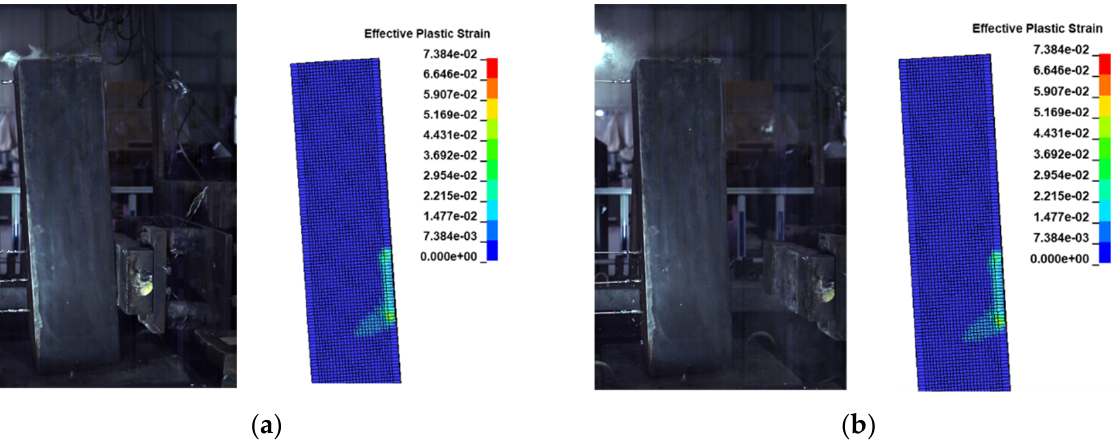
Figure 11. Experiment and finite element failure modes. ( a ) Displacement peak of test and FE ( b ) Residual displacement of test and FE.